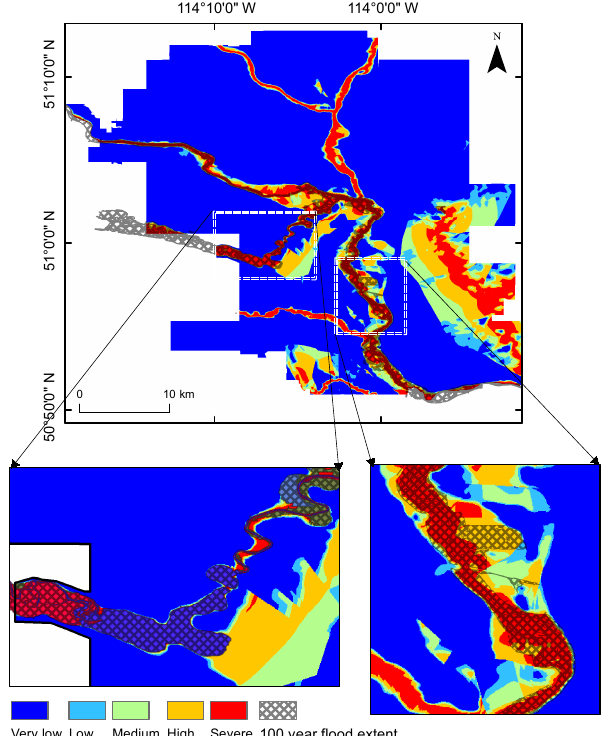
Figure 4. Comparison of hazard map obtained from the present study and a 100-year-flooding extent map prepared by the city of Calgary (hatched portions). Portions of the reach along the Bow and Elbow rivers are enlarged to show the level of agreement between both maps.